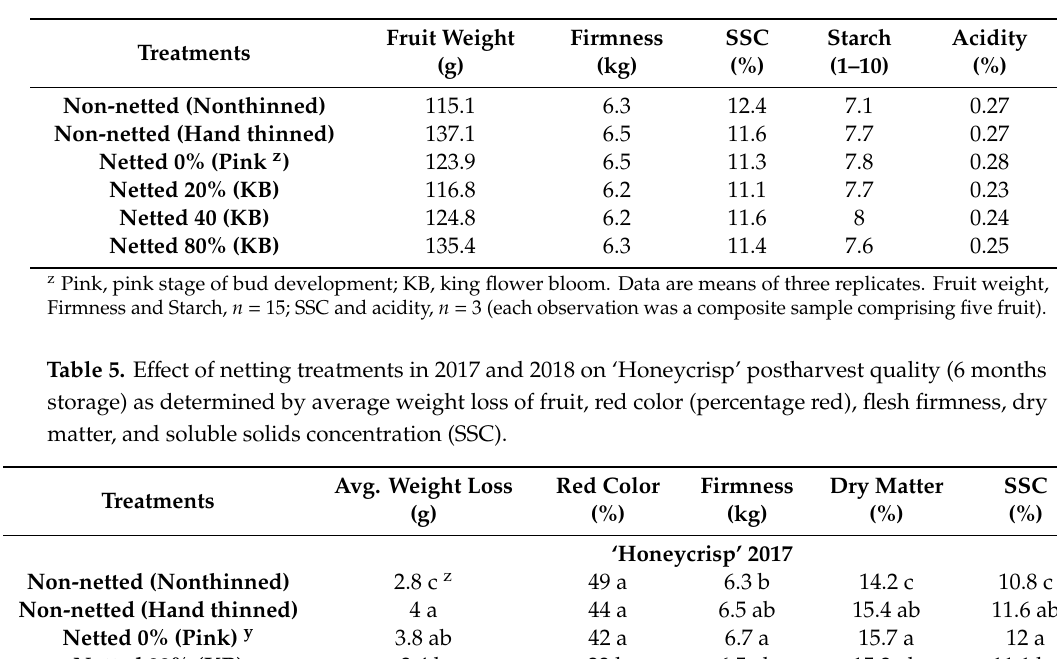
Table 4. E ff ect of netting treatments in 2018 on ‘Gala’ postharvest quality (3 months storage) as determined by average fruit weight and fruit quality attributes; flesh firmness, soluble solids concentration (SSC), starch, and titratable acidity.